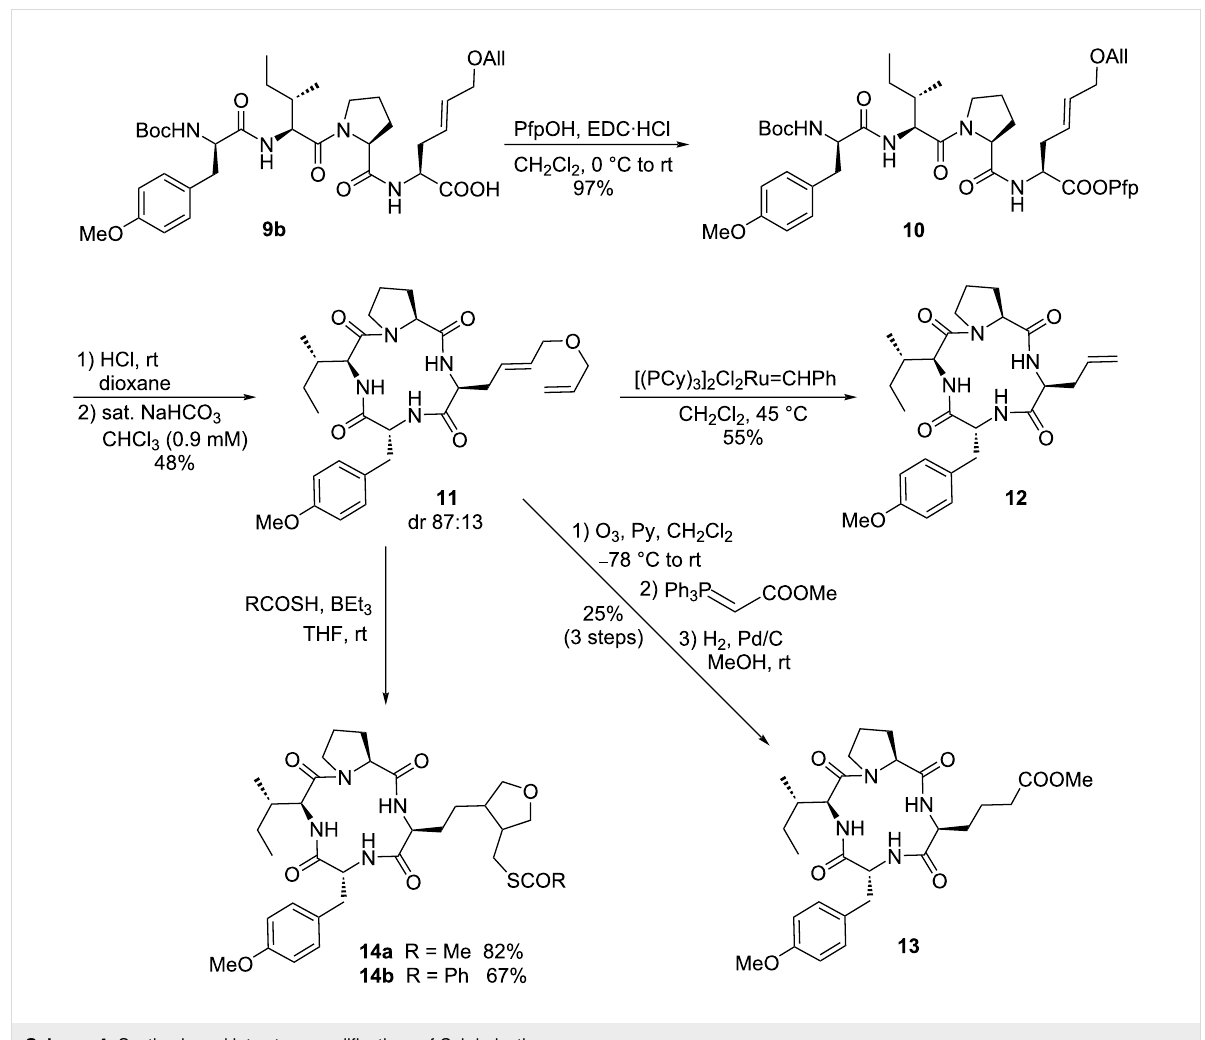
Scheme 4: Synthesis and late stage modifications of Cyl